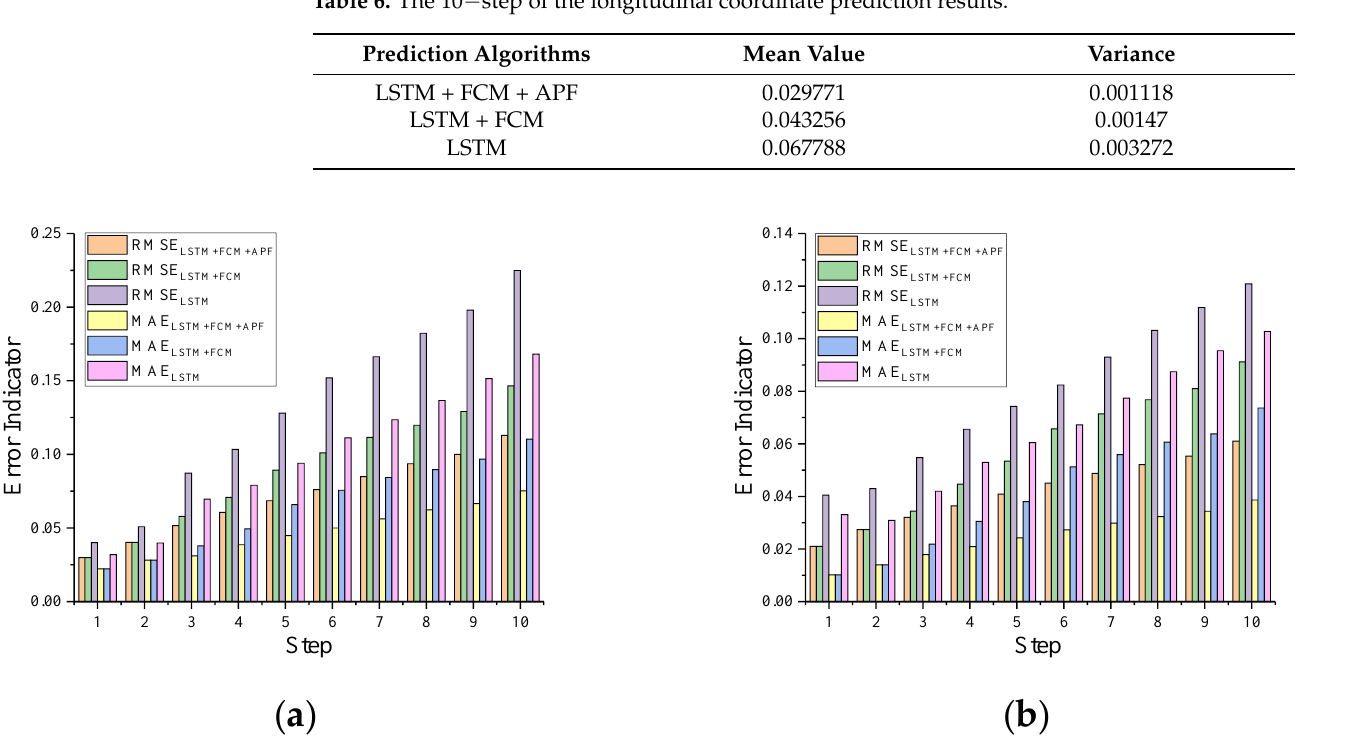
Table 6. The 10 − step of the longitudinal coordinate prediction results.